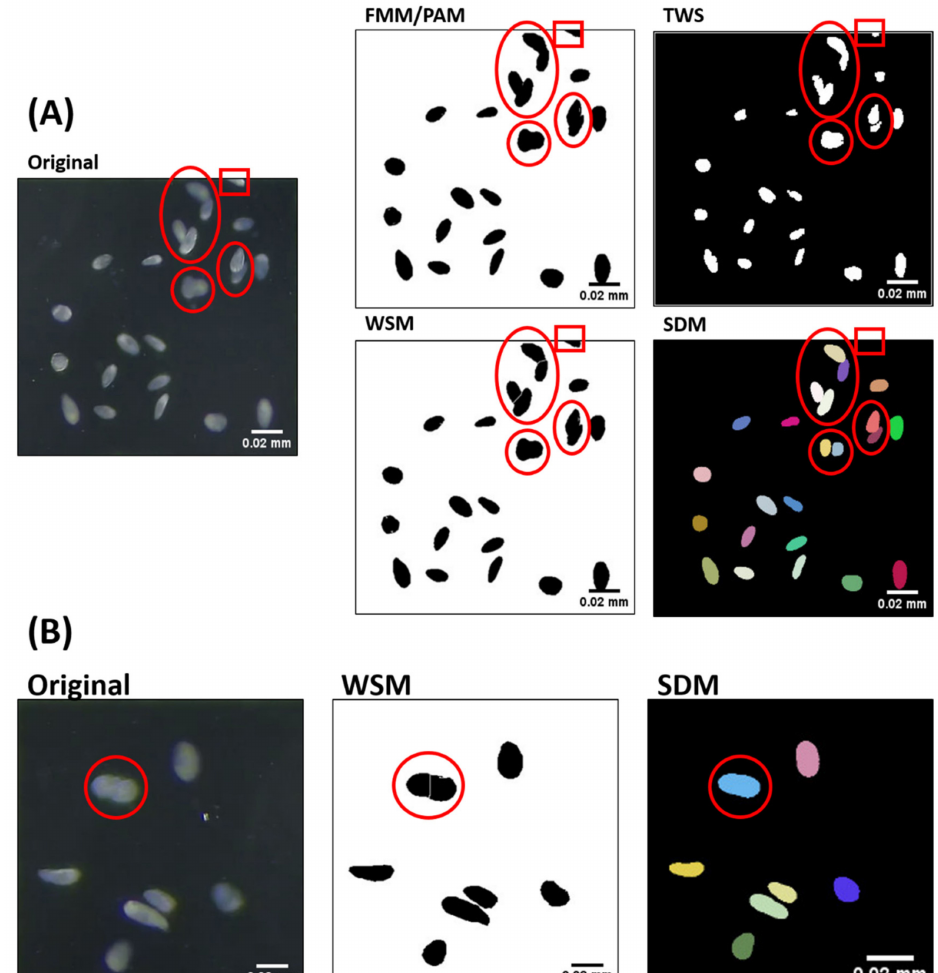
Figure 4. Images depicting segmentation results obtained from different Tetrahymena cell counting methods. ( A ) FMM/PAM and TWS showed the inability of segmenting overlapping Tetrahymena cells. In contrast, WSM showed limited segmentation, while SDM showed better segmentation. Segmented cells are marked with red circles, but misdetection on edge is marked with red rectangle. ( B ) Images showing segmentation error by WSM compared to SDM during cell division. Tetrahymena marked with red circle is undergoing binary fission, and it is still counted as single cell. This Tetrahymena was recognized as two cells by WSM due to the segmentation